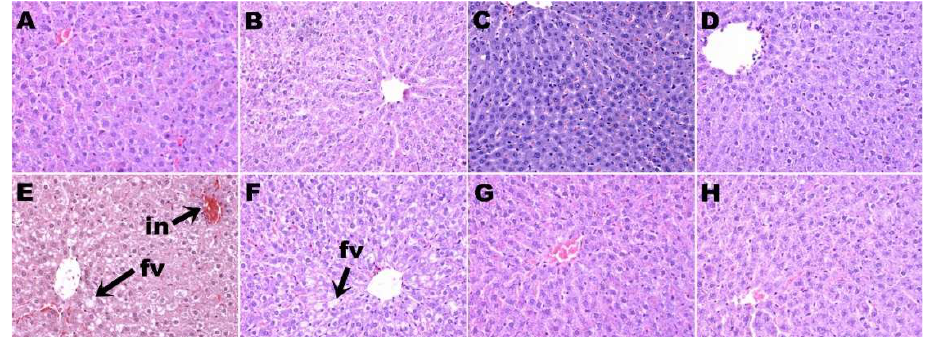
Figure 4. Hematoxylin and eosin staining of liver showing fat vacuoles and infiltration of inflammatory cells (magnification ×20; shown by arrows) in corn starch diet-fed rats ( A ), corn starch diet-fed rats treated with whole linseed ( B ), corn starch diet-fed rats treated with defatted linseed ( C ), corn starch diet-fed rats treated with SDG ( D ), high-carbohydrate, high-fat diet-fed rats ( E ), high-carbohydrate, high-fat diet-fed rats treated with whole linseed ( F ), high-carbohydrate, high-fat diet-fed rats treated with defatted linseed ( G ), and high-carbohydrate, high-fat diet-fed rats treated with SDG ( H ). Fat vacuoles are marked as “fv” and inflammatory cells are marked as “in”.